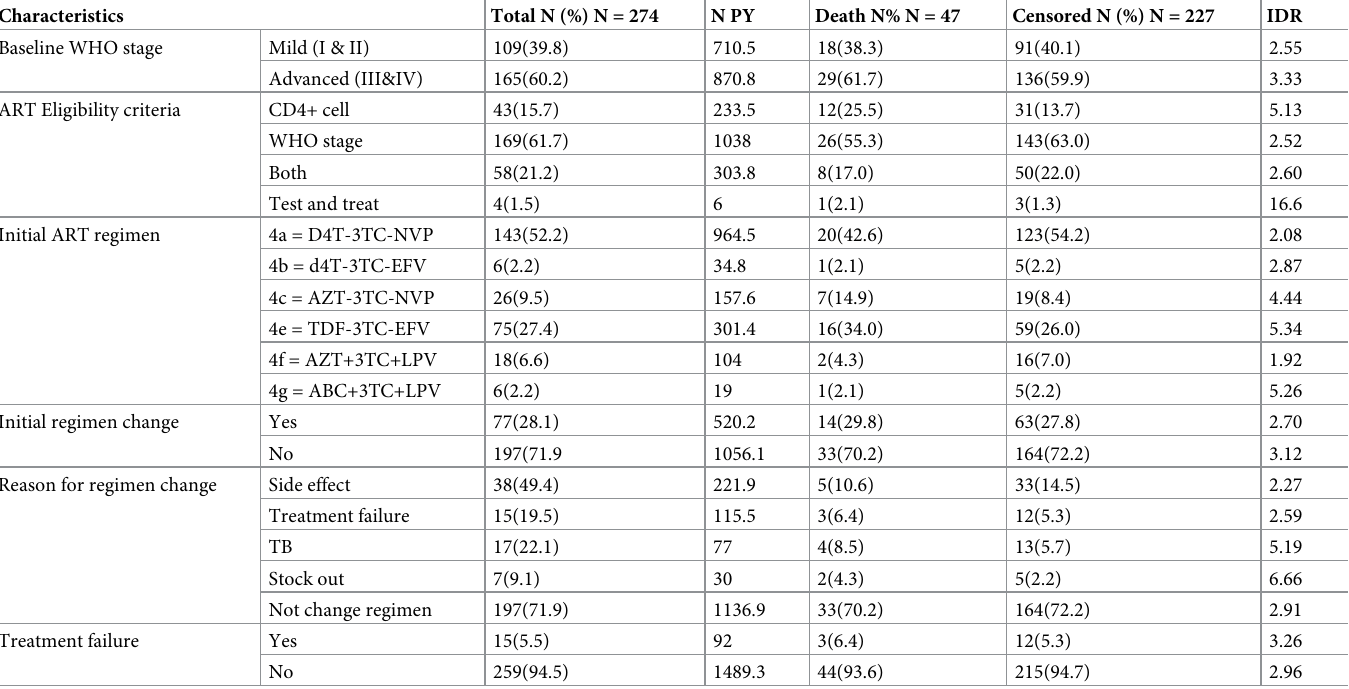
Table 2. Clinical characteristics of TB/HIV co-infected children at public hospitals Southern Ethiopia, 2020.